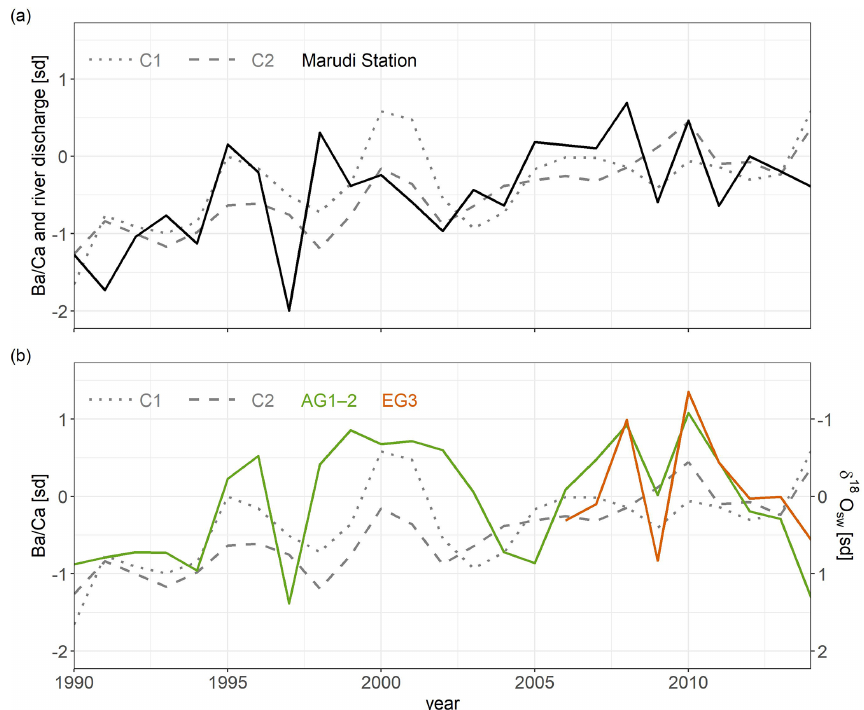
Figure 5. (a) Mean annual Ba / Ca composite time series C1 and C2 (in grey dotted and dashed lines, respectively) and river discharge using data from Marudi station (in black) and (b) Ba / Ca composites time series with δ 18 O sw records AG1–2 (light green) and EG3 (orange), respectively. Note that the δ 18 O sw axis is reversed.